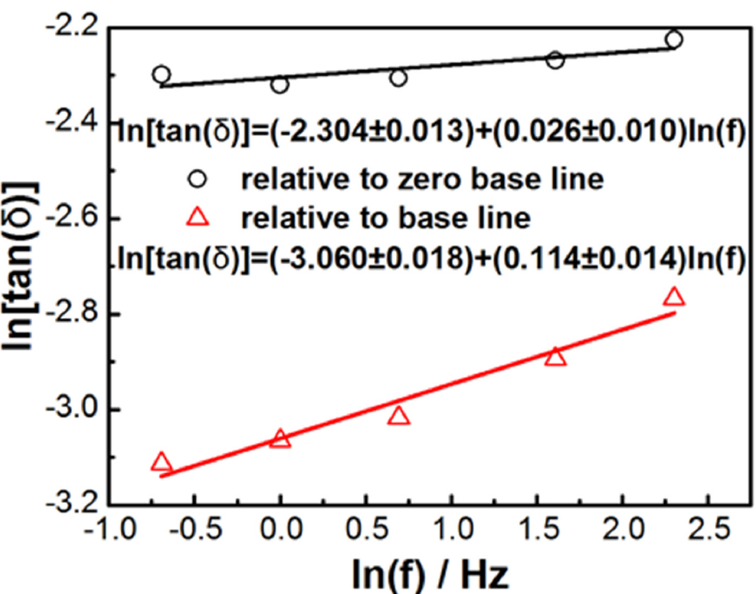
Figure 9. Double logarithmic plot ln(tan δ ) vs. ln(f) for the peak height of tan δ near 164 K for [(CH 3 ) 2 NH 2 ][Fe(HCOO) 3 ] pellets fitting by power law tan δ = Af n . The peak height of tan δ near 164 K was obtained using two methods. The first was relative to zero base line, i.e., no base line correction was used. The second was relative to the baseline, which was tangential to data points near 130 K and 180 K. n was